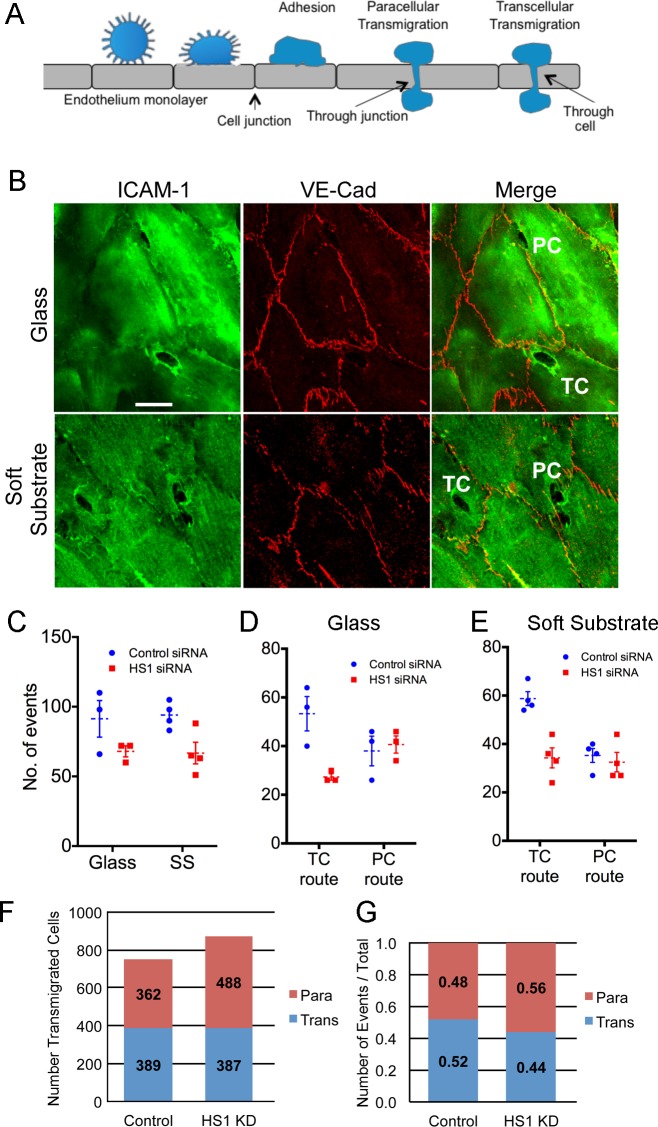
Transcellular vs paracellular route of TEM.A) Diagram illustrating paracellular and transcellular routes. B) Representative confocal fluorescence images of cells taking the paracellular (PC) and transcellular (TC) routes. The migrating NK cells appear as small dark holes surrounded by intense anti-ICAM-1 staining, and the endothelial cell-cell junctions are visualized by anti-VE-cadherin staining. The endothelial cell substrate was glass in the upper panel and soft substrate (polyacrylamide) in the lower panel. Scale bar = 10 μm. C) Total number of transendothelial migration events, with the endothelial monolayer on glass or soft substrate (SS). D) Numbers of paracellular and transcellular transmigration events on glass. E) Numbers of paracellular and transcellular transmigration events on soft substrate. For panels D to F, each plotted data point represents the average of three values from one experiment. The mean and standard error of the values of the plotted points are also indicated, by the dotted lines and error bars. HDMVEC cells were washed with SDF-1α-containing media before the addition of NK cells, and NK cells were incubated for 2 hrs on the monolayer before fixation. F and G) Transendothelial migration events and routes. NK cells were incubated for 25 min on the surface of an HDMVEC monolayer. NK cells migrated via transcellular and paracellular routes were counted over entire slide. The data are based on experiments in triplicate on two different days. F) Numbers of events. G) Ratios. The difference in the ratio of transcellular to paracellular events between control and HS1 knockdown is small but statistically significant because the number of data points is large. Based on a 2 x 2 contingency table, Fisher’s exact two-tailed p-value is 0.0024.